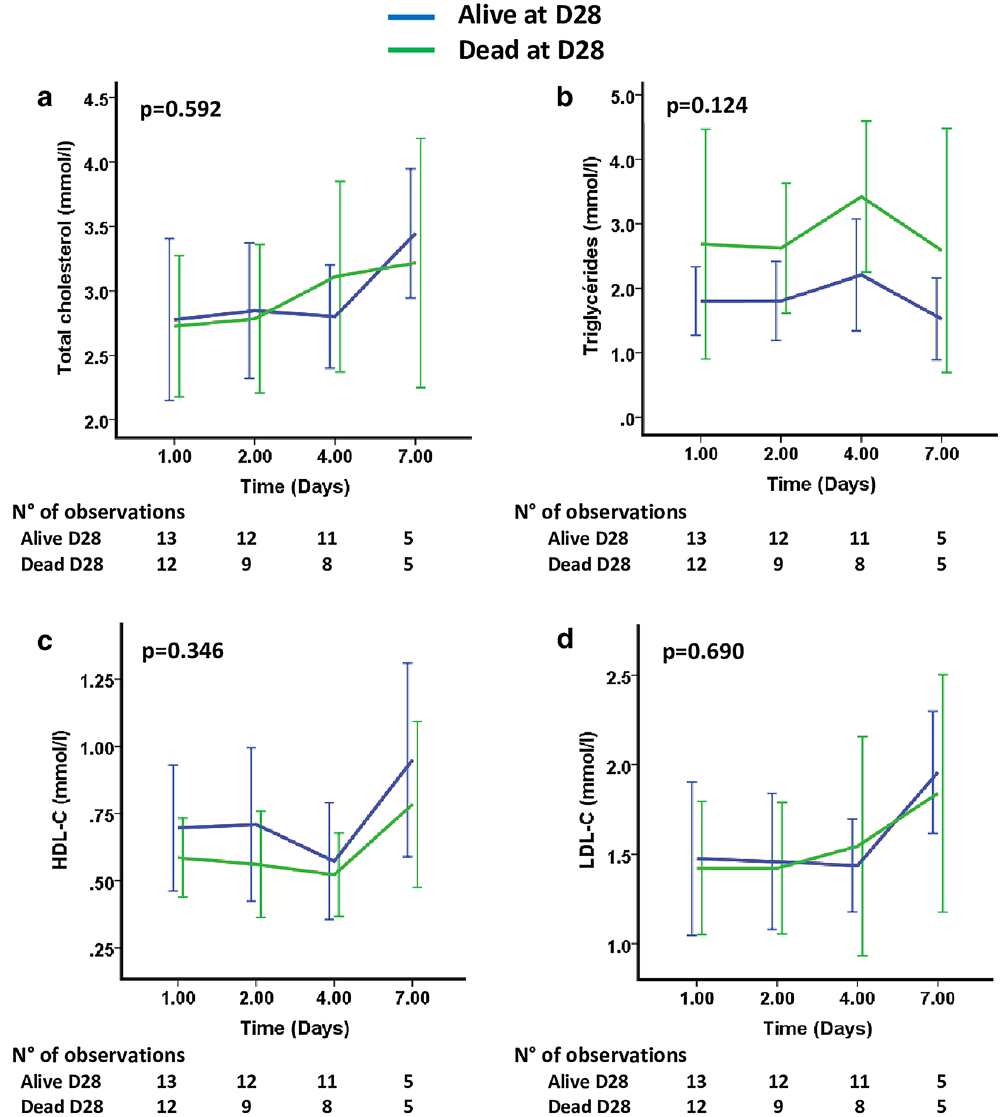
Figure 2. Mean (95% CI) variations of lipoprotein concentrations during the first seven days following admission according to Day-28 mortality. Group comparison ( p value) was performed using a mixed model. ( a ) Total Cholesterol (TC), ( b ) Triglycerides (TG), ( c ) High-density lipoproteins cholesterol (HDL-C) and ( d ) Low- density lipoproteins cholesterol (LDL-C) concentrations throughout the ICU